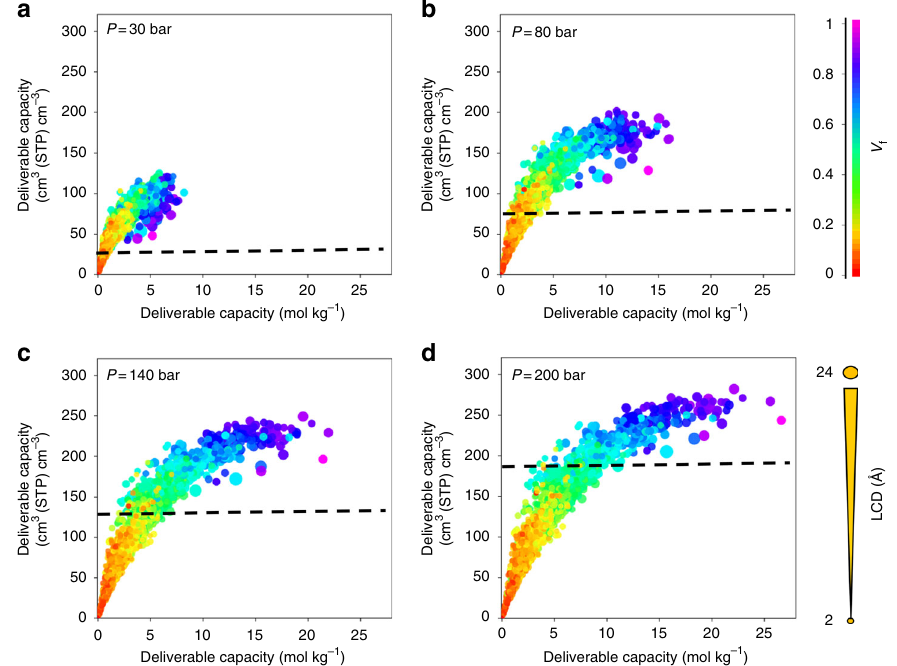
Fig. 4 Structure – property relationships for oxygen storage in MOFs. Oxygen volumetric and gravimetric deliverable capacity is plotted vs. the largest cavity diameter (LCD) and void fraction ( V f ) for 2,932 MOF structures at a 30 bar, b 80 bar, c 140 bar and d 200 bar storage pressures and 298 K. The release pressure is kept fi xed at 5 bar for all storage pressures. The dashed lines mark the amount of oxygen adsobed in an empty tank. Each point in the graph represents a different structure. The data points are color coded and sized according to V f and LCD,